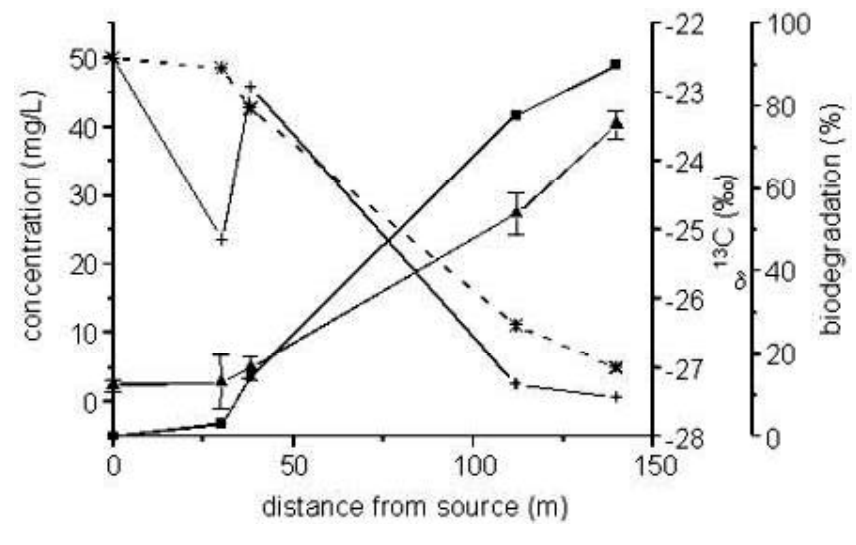
FIGURE 3. Concentration (crosses) and isotope composition (triangles) of toluene along the monitoring profile depicted in Fig. 2. The percentage of biodegradation (squares) and the residual substrate fraction (stars) were calculated with Eqs. 4 and 5 using an isotope fractionation factor characteristic for anaerobic biodegradation of